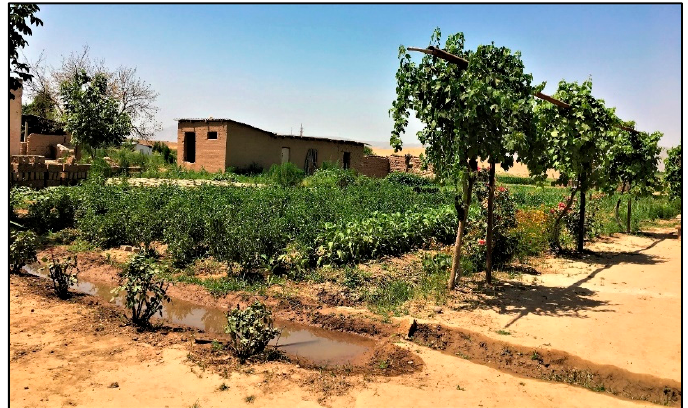
Figure 2. Kitchen garden in Nosiri Khusrav district, Tajikistan.